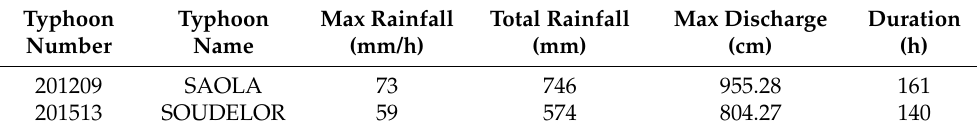
Table 5. Typhoon events for the HEC-HMS model validation. Typhoon